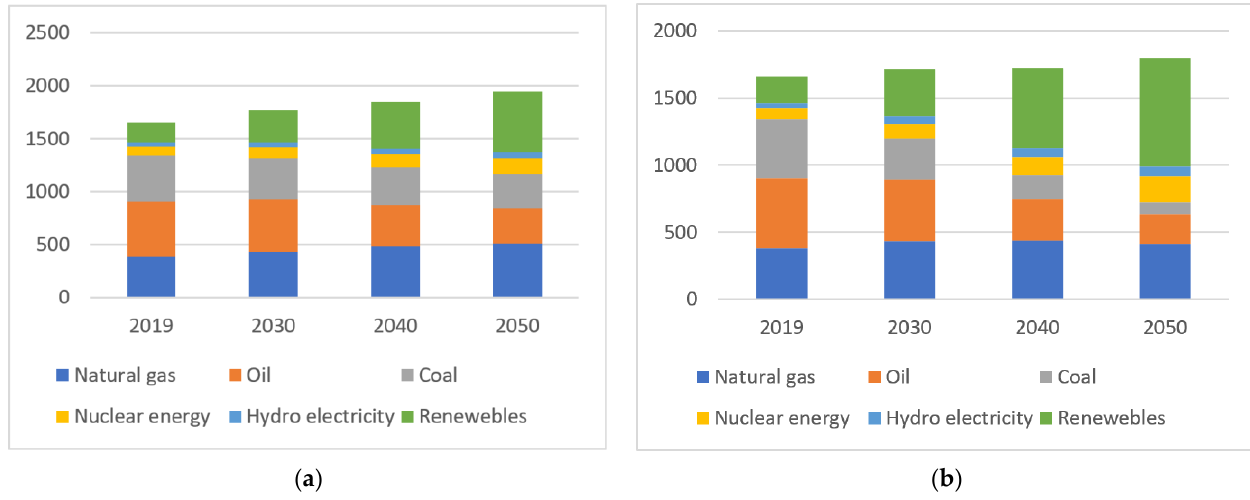
Figure 2. World demand for primary energy. ( a ) The momentum scenario, PJ/d; ( b ) The rupture scenario, PJ/d [7].